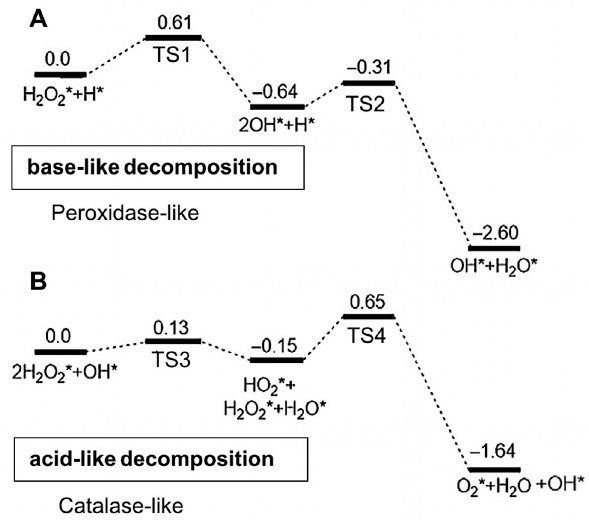
Figure 5. Calculated reaction energy profiles (unit: eV) for hydrogen peroxide decomposition on an Au(111) surface in ( A ) acidic and ( B ) basic conditions. Asterisk (*) is used to indicate species adsorbed on the metal surface. TS stands for transition state. (Adapted with permission from [35].